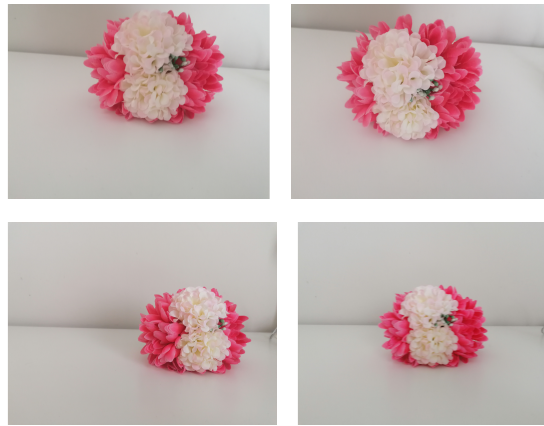
Figure 2 . A selection of the images contained in the dataset “flower”.